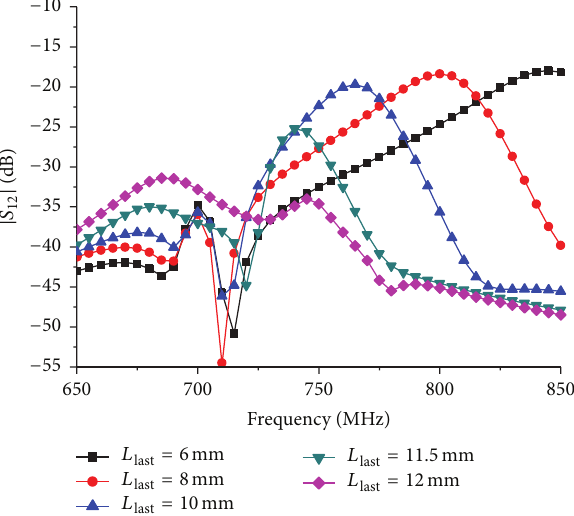
Figure 5: |𝑆 12 | curve of MIMO antenna with different 𝐿 last